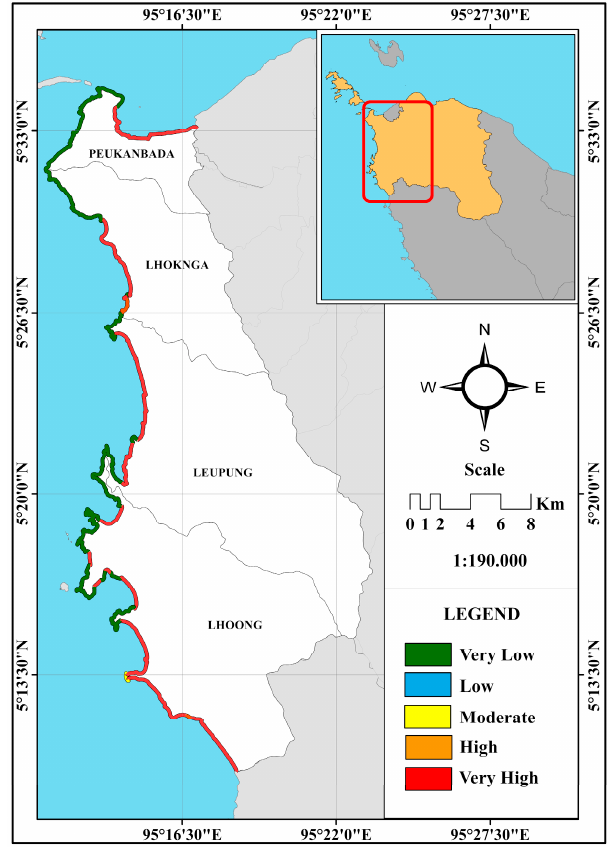
Figure 3. The level of coastal vulnerability based on coastal geomorphology on the west coast of Aceh Besar district. Table 4. Percentage of coastal vulnerability in terms of coastal morphology . Geomorphological Vulnerability Sub-District